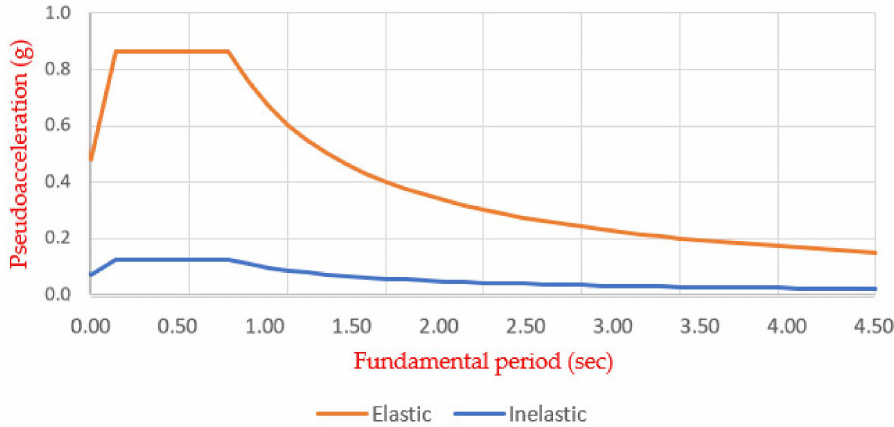
Figure 1. Elastic and inelastic response spectrum of a house located in the north of Guayaquil.